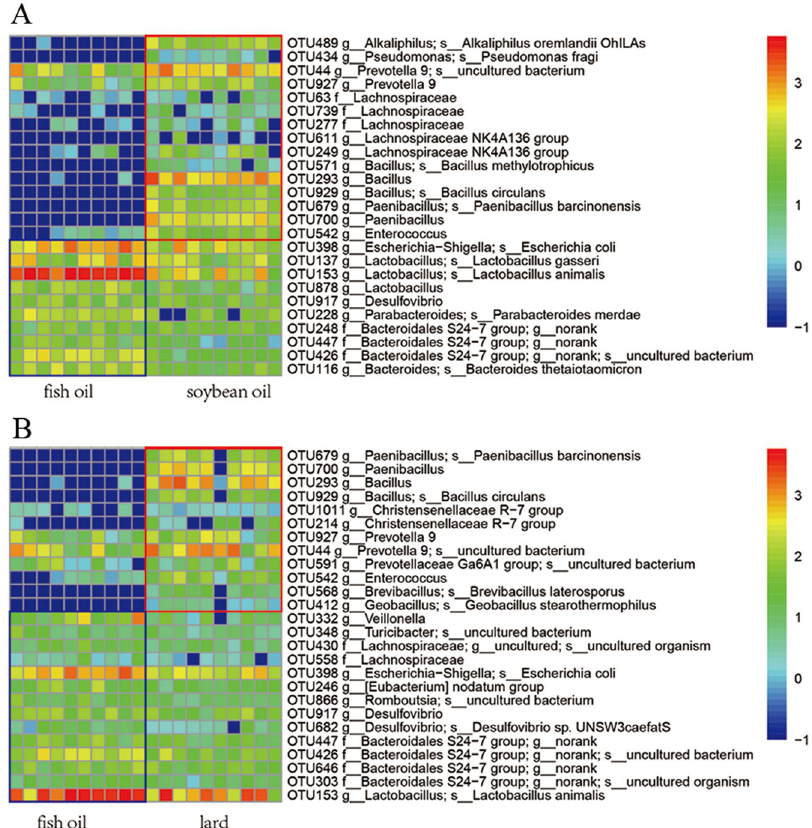
Figure 5. Comparisons of bacteria in fermentation liquids using LefSe. ( A ) Between fish oil and soybean oil groups. ( B ) Between fish oil and lard groups. The left histograms show the LDA scores computed for features on the OTU level. The heatmaps shows the relative abundance of OTU (log 10 transformed). Each column represents one biological sample and each row represents the OTU corresponding to the right